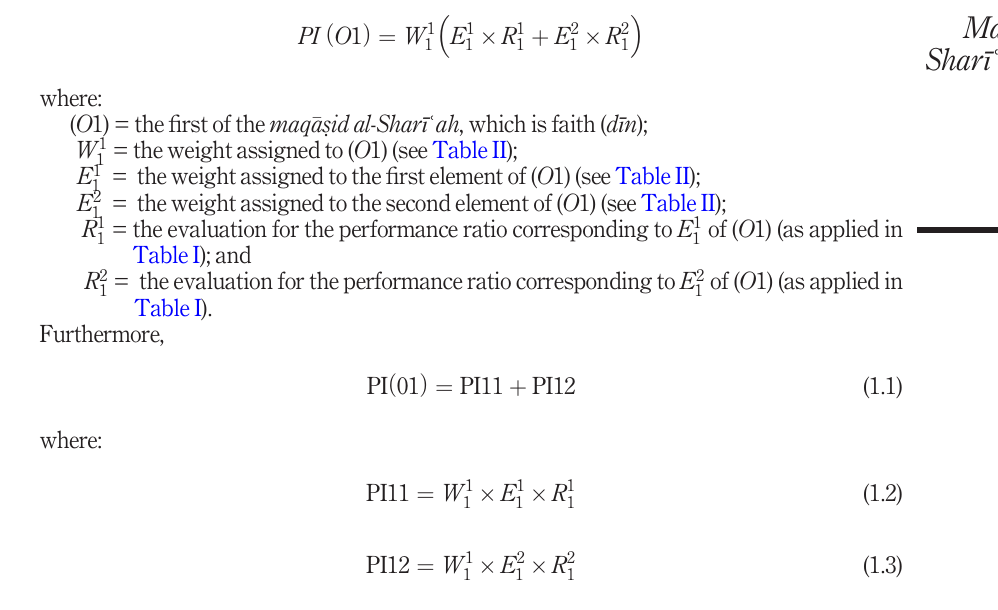
of ( O 1) (as applied 1